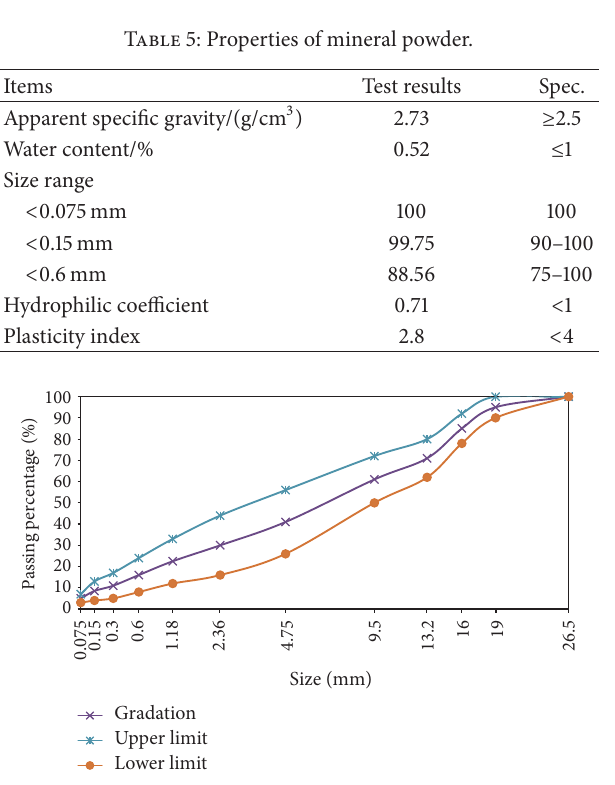
Figure 1: Gradation of aggregates in AC-20 asphalt